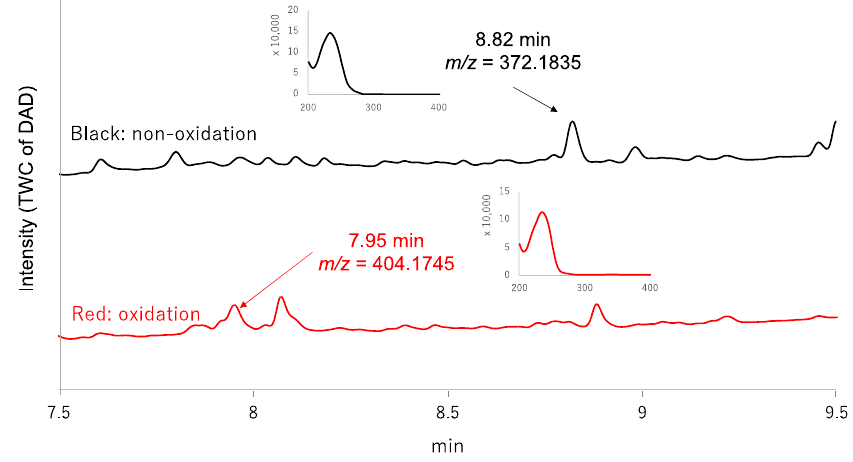
Figure 1. Comparison of total wavelength chromatograms (TWCs) obtained from liquid chromatography-mass spectrometry (LC / MS) analysis of the oxidized and non-oxidized culture broth of the strain FKI-7382. Table 1. 1 H and 13 C NMR chemical shifts of 1 and 2